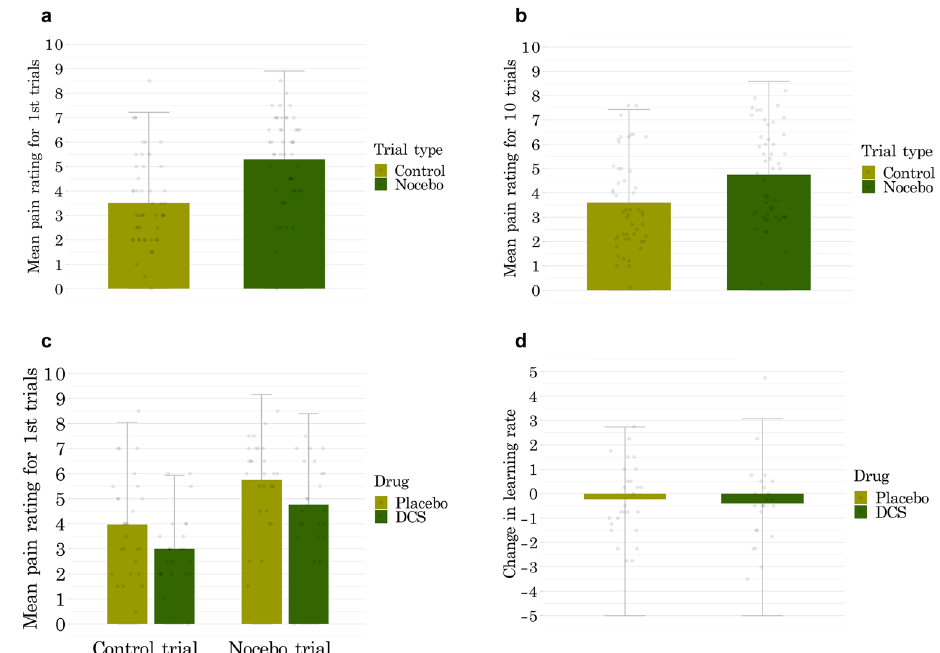
Figure 3. Behavioral results represented as group means and standard deviations. Dots in the figure represent individual data points. There was a significant nocebo effect in the first pair ( A ) and first 10 trials of extinction ( B ). Nocebo responses were not affected by D-cycloserine (DCS) compared to placebo ( C ). Learning rates were measured on the WMS-IV before and after DCS administration ( D ). There was only a slight non-significant reduction in learning rates of all participants, irrespective of drug group.